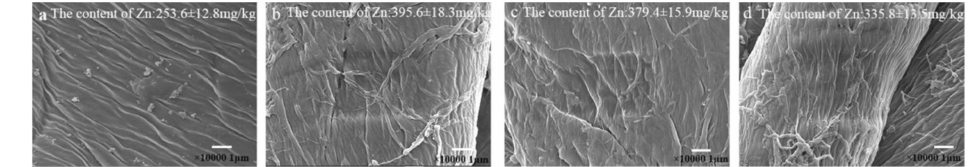
Figure 9. SEM images and Zn element contents ofZnO/cotton ( a ), OA-ZnO/cotton ( b ), TA- ZnO/cotton ( c ) and SA-ZnO/cotton ( d ) after 10 cycles of washing.